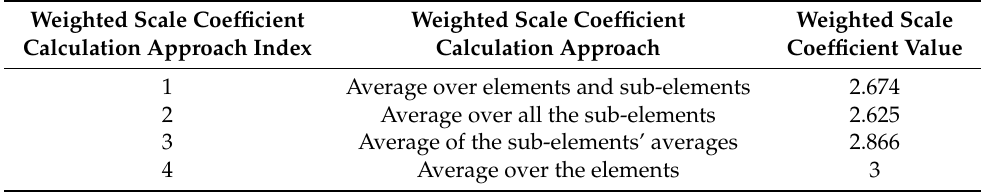
Table 7. Weighted scale